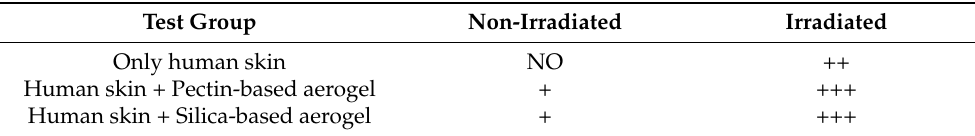
Figure 9. Histological images (H&E staining) of human skin ex vivo grafts subjected or not to laser irradiation directly or combined with a pectin ‐ based or silica ‐ based aerogel structure. All images are representative of each test group. Scale bar: 250 μ m. Table 2. Relative degree of lesion of the skin alterations observed for each one of the human skin test groups.